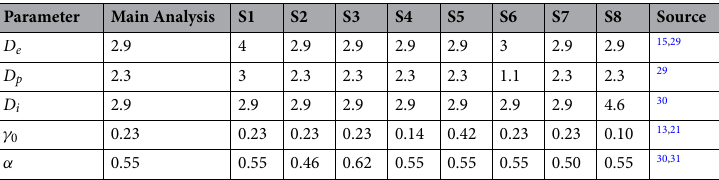
Table 5. Description of essential model parameters that were not fitted in the MCMC, where D e refers to the latent period, D p refers to the pre-symptomatic infectious period, D i refers to the symptomatic infectious period, γ 0 refers to the initial ascertain rate and α refers to the ratio of the transmission rate for P and A to I .